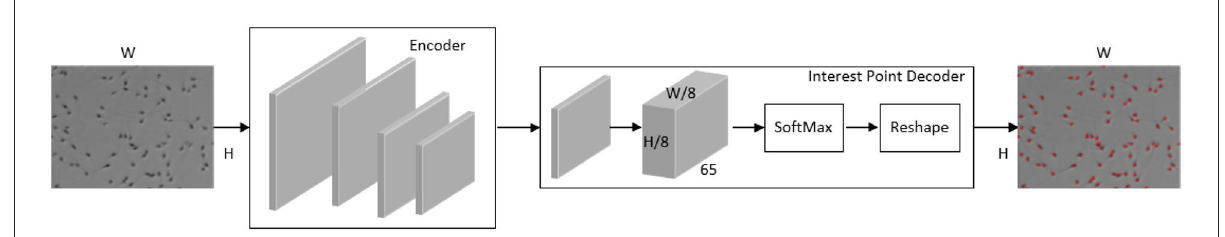
FIGURE1 Modified SuperPoint network structure diagram. After deleting the descriptor detection branch, it has no effect on the feature point detection branch, and accelerates the network detection speed of the sperm target location.